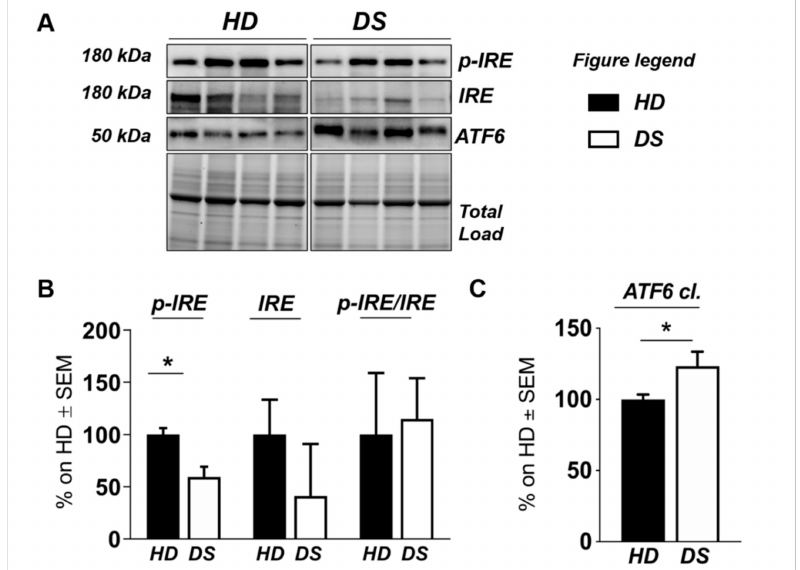
Figure 5. Human PBMCs from DS individuals show selective activation of the unfolded protein response. ( A ) Representative Western blot showing ATF6, p-IRE1, and IRE1 in PBMCs from DS and HD. ( B ) Quantification of panel (A) showing levels of total ATF6. ( C ) Quantification of panel (A) showing levels of pIRE1 / IRE1 ratio. Densitometric values shown in the bar graph are the mean of eight samples for each group normalized for total load and are given as percentage of HD, set as 100%. Statistical significance was determined using Student t -test analysis (* p <